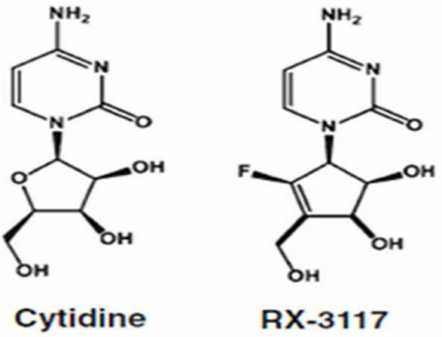
Figure 1. Chemical structure of cytidine and the cytidine analog